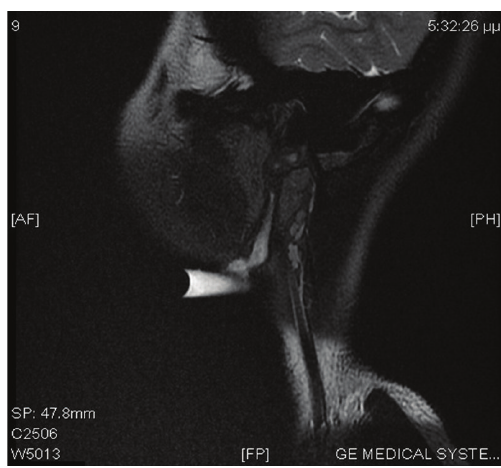
Figure 5: Lateral view T1-contrast enhanced MRI demonstrating the fistula and its extension to the acoustic meatus.